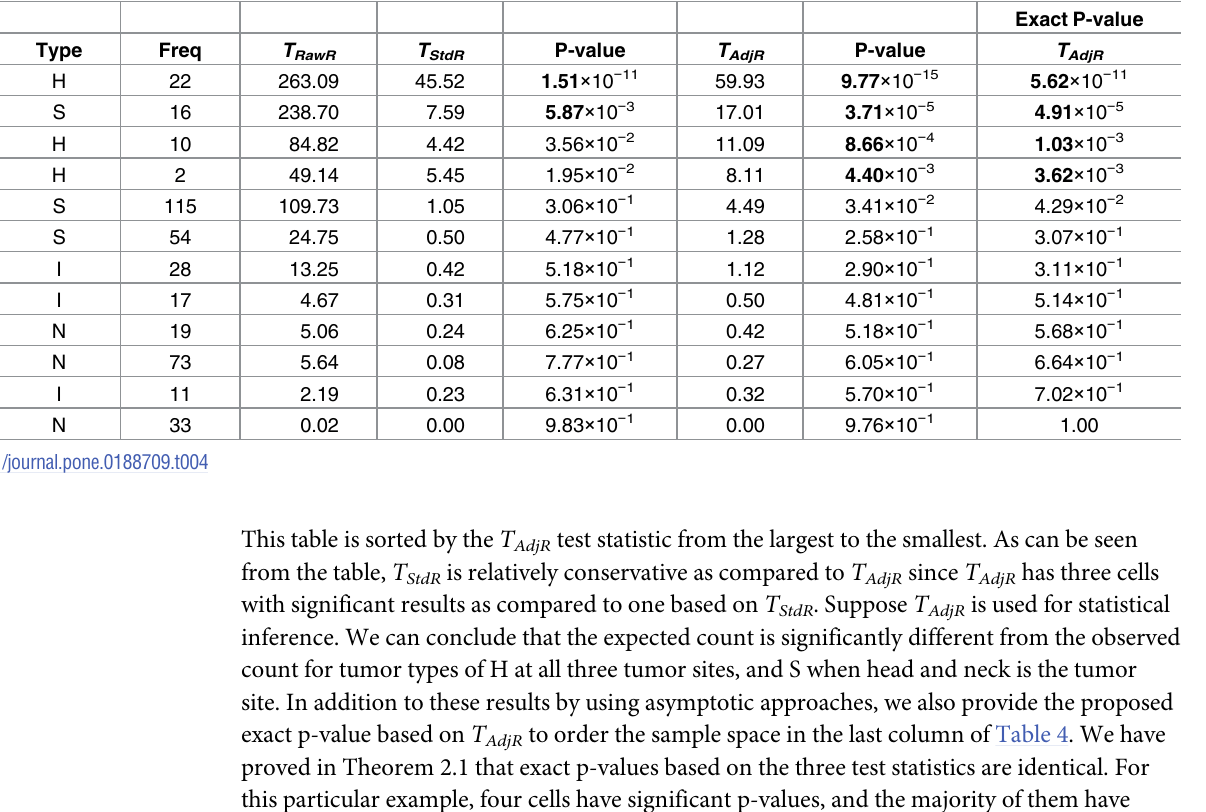
Table 4. P-value calculation for each cell of data from the malignant melanomaexample. The calculatedp-valuefor eachcell is comparedto the multiple comparisoncorrection method by Simes [18]. The cells with significantp-values are bold.